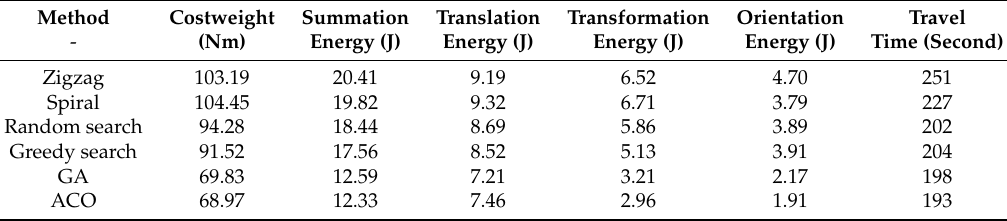
Table 4. Averaged energy and time evaluation for realtime testbeds. The measured electrical energy in (Ws) unit has been converted to (J) unit to describe the mechanical